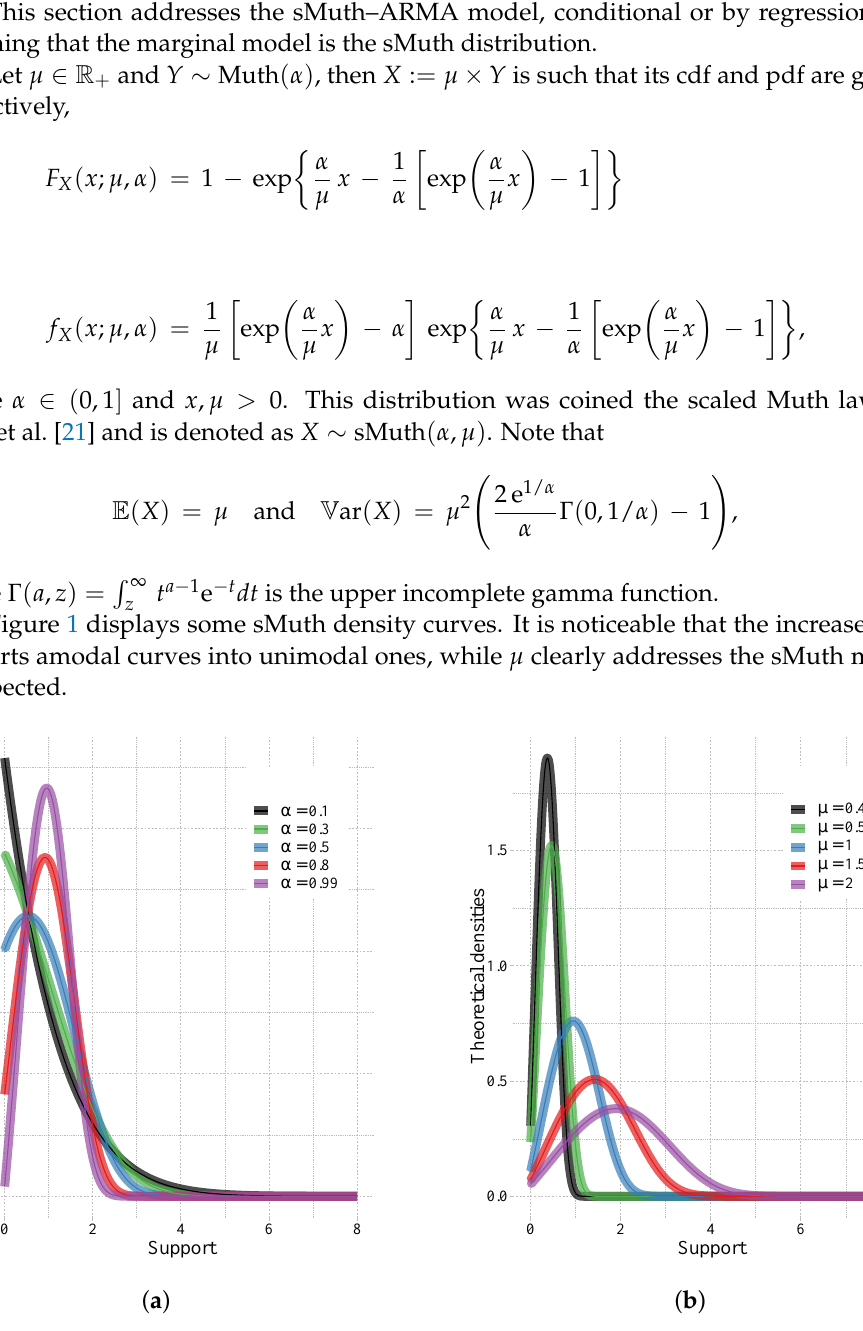
Figure 1. The sMuth density curves for θ = ( α , µ ) . ( a ) µ = 1 and α = 0.1, 0.3, 0.5, 0.8 and 0.99. ( b ) α = 0.9 and µ = 0.4,0.5,1,1.5 and